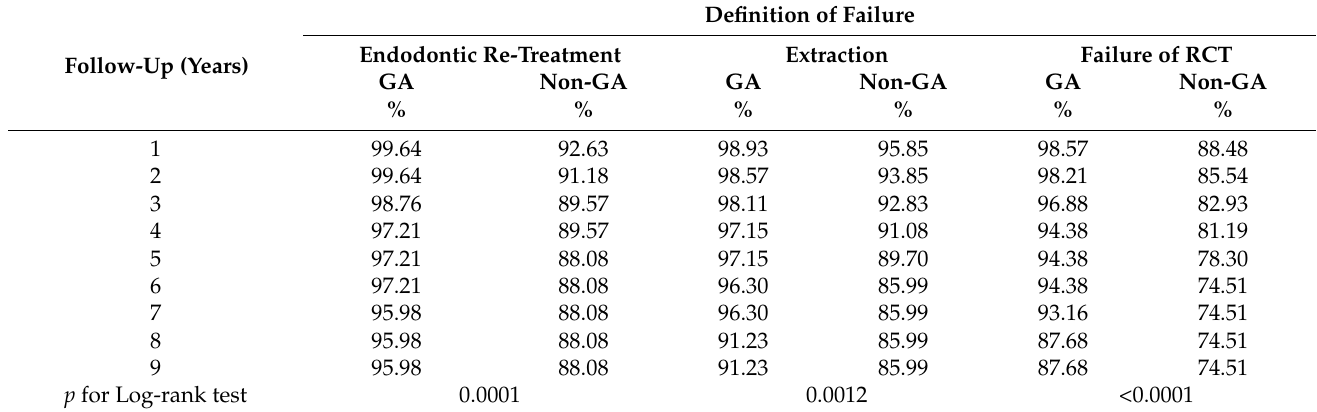
Table 2. Cumulative survival rate of RCT failure in patients treated with and without general anesthesia according to various endpoints.